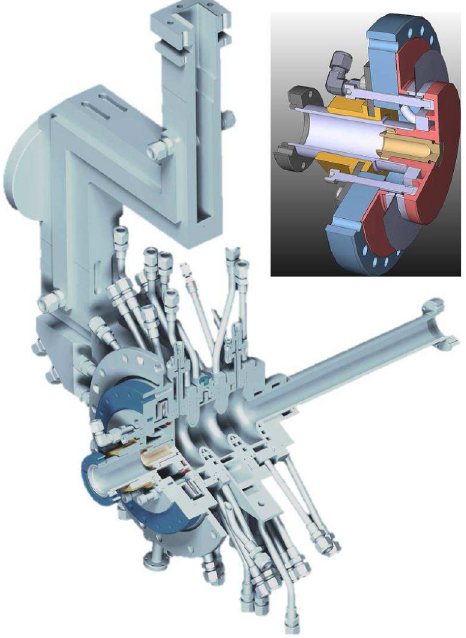
FIG. 4. Cutaway 3D views of the SwissFEL gun. Details of the backplane and the cathode plug are also visible in the upper right figure.